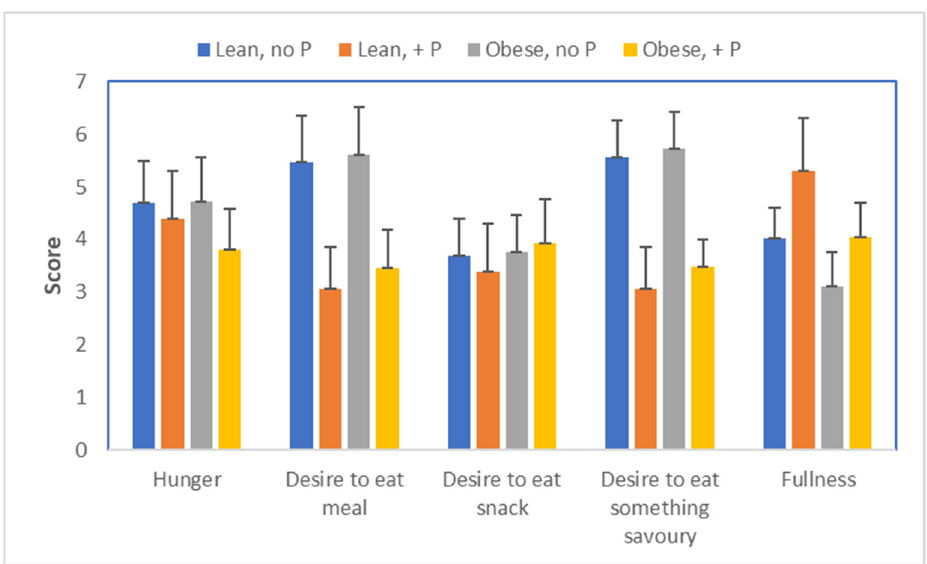
Figure 14. Appetite scores, 3 h after drinking a solution containing 75 g glucose, as affected by phosphate supplementation in lean and obese individuals [34].